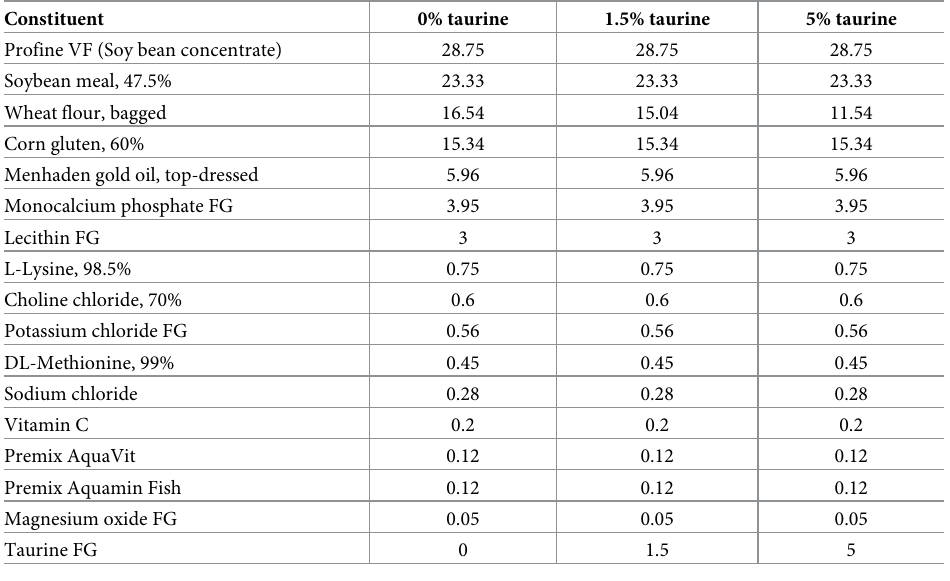
Table 1. Formulations for the three experimental diets on a dry-matter-basis. Constituent